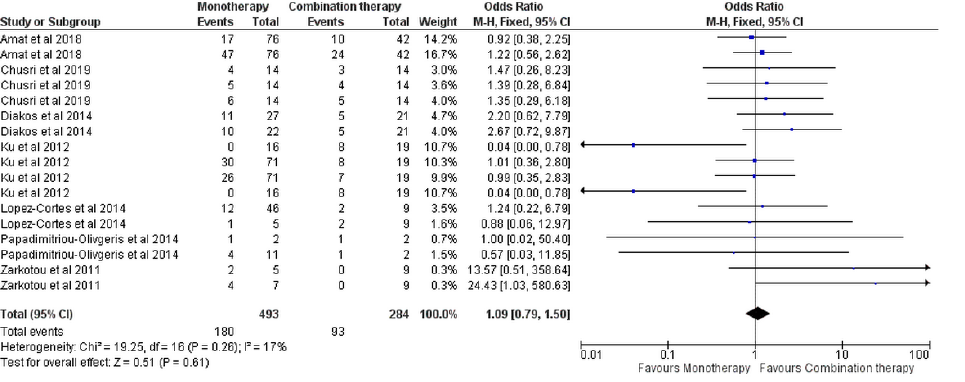
Figure 6. Clinical response of monotherapy versus combination monotherapy [7,13–16,18,24]. The 30-day mortality also did not differ between the monotherapies and the combi- nation, as reported by six studies [7,13–15,18,24] (OR = 1.12, 95% CI [0.73, 1.71], p = 0.59), Figure 7. No significant heterogeneity was observed (I 2 = 0%, p = 0.53). Possible publication bias was observed, Figure S1.9, and when this was improved by excluding the subgroup of Ku et al. [15], with OR = 0.04, 95% CI [0.00, 0.78], the outcome did not change (OR = 1.37, 95% CI [0.88, 2.14], p =